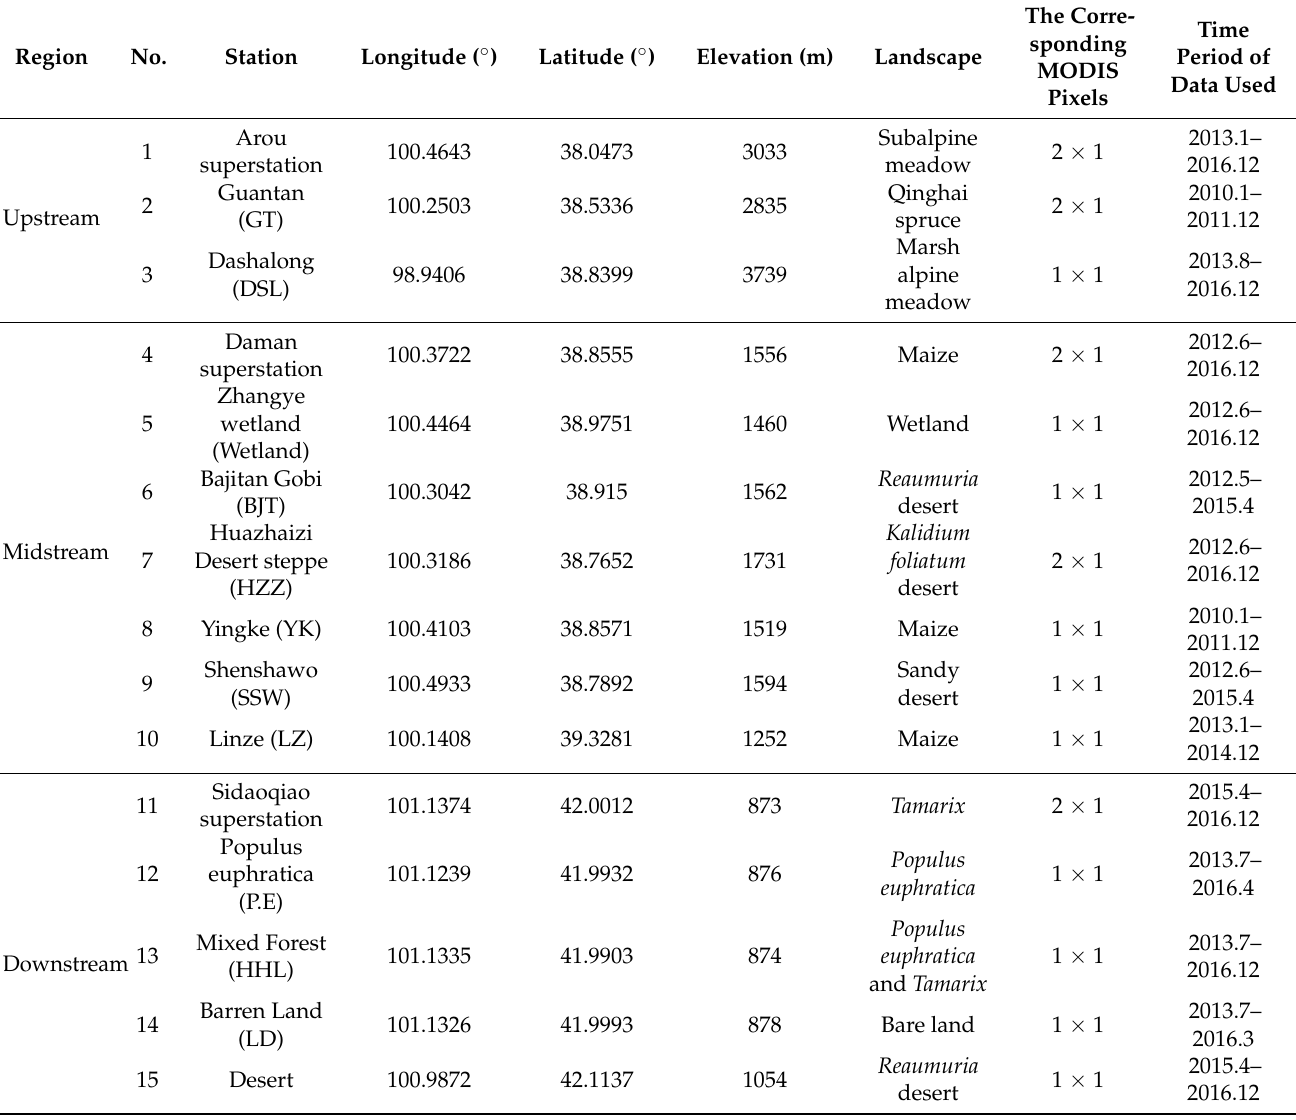
Table 1. Specifications of the stations in the HRB used in this